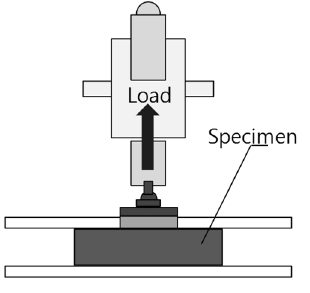
Figure 11. Tensile bond strength test.